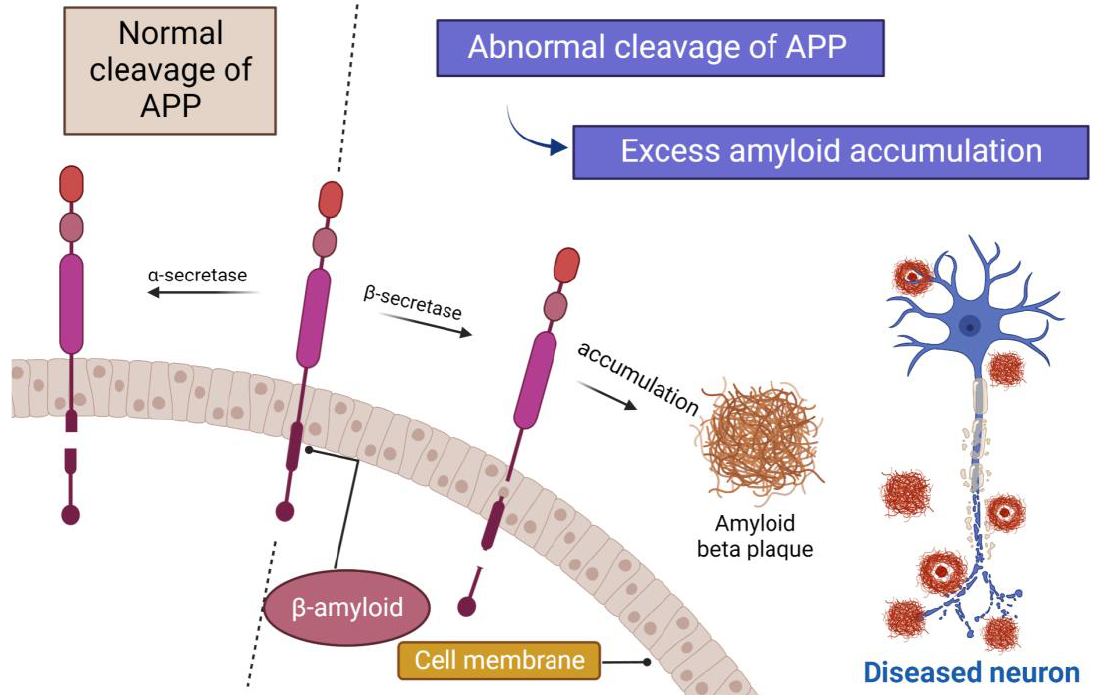
Figure 6. Cleavage of APP. In the normal conditions, APP is cleaved by α -secretase. In abnormal conditions, APP will be cleaved by β -secretase, resulting in the accumulation and aggregations of small peptides called β - amyloid (Aβ), with the formation of amyloid plaques.